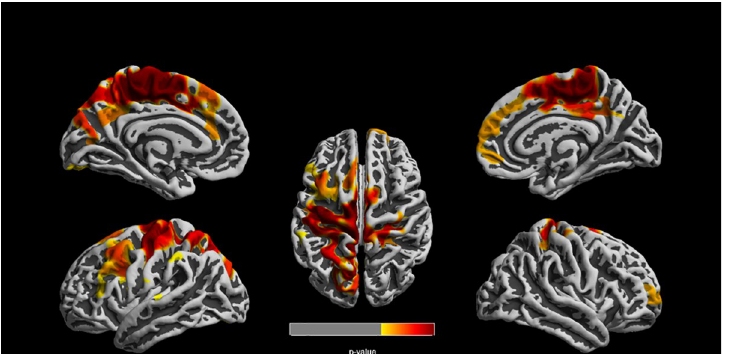
Fig 1. Statistically significant clusters using threshold free cluster enhancement. Clusters represent reduced cortical thickness in the high ECAT group compared to the low ECAT group. Clusters were corrected for multiple comparisons using a familywise error rate of p �